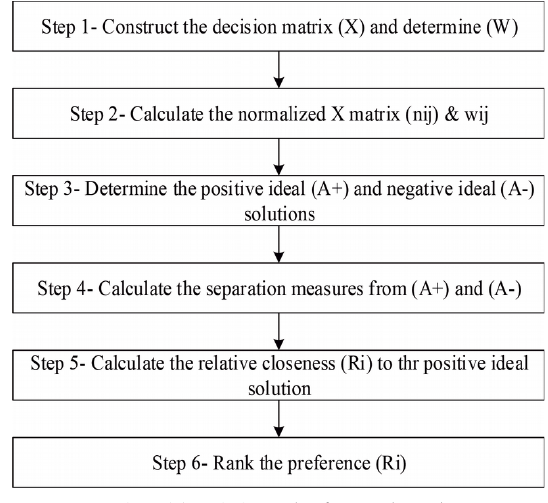
Figure 7. Step TOPSIS Methods (Rozkowska,